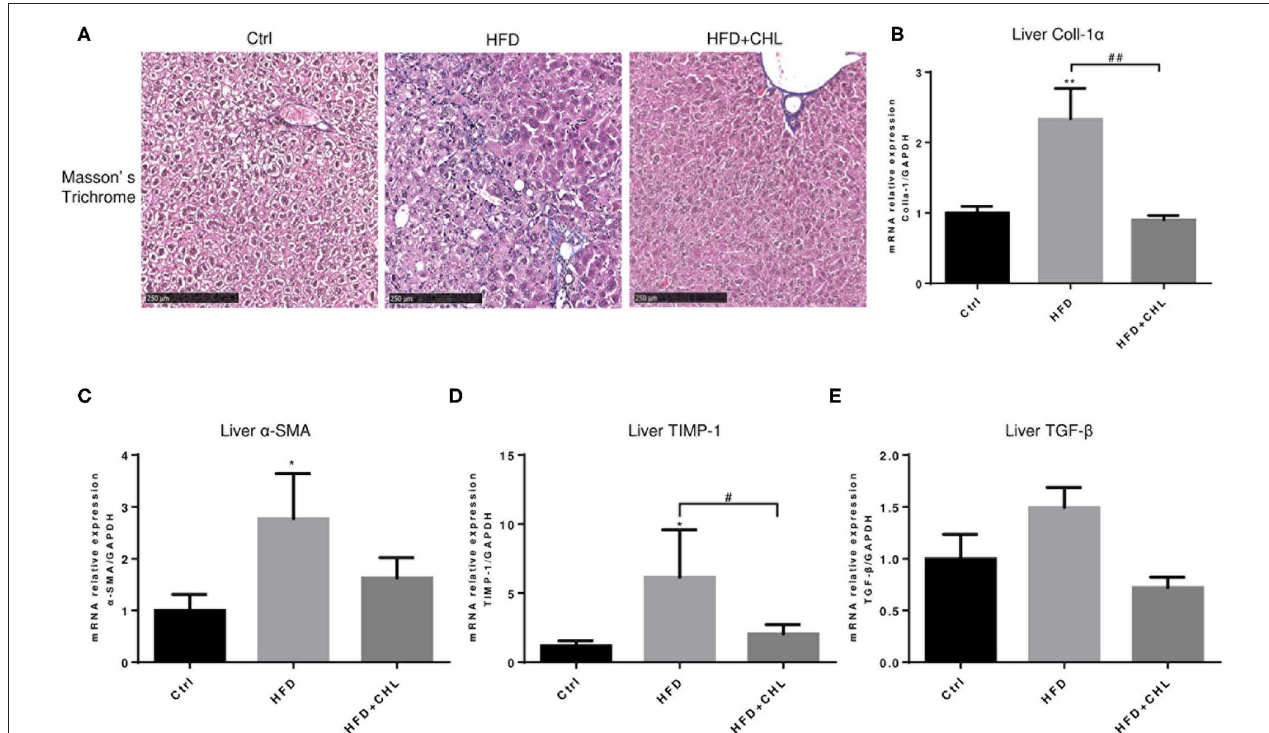
FIGURE 5 | CHL improves liver fibrosis of the mice fed with an HFD. (A) The experimental condition is described in Figure 1 . The liver fibrosis was determined by Masson’s Trichrome staining. Hepatic expression of (B) Type-I collagen alpha, (C) alpha-smooth actin, (D) tissue inhibitor of matrix metalloproteinase-1, and (E) transforming growth factor beta-1 was determined by RT-qPCR analysis and n = 6–8 for each group. Values are mean ± SEM; * p < 0.05, ** p < 0.01 vs. Ctrl group; # p < 0.05, ## p < 0.01 vs. HFD group.